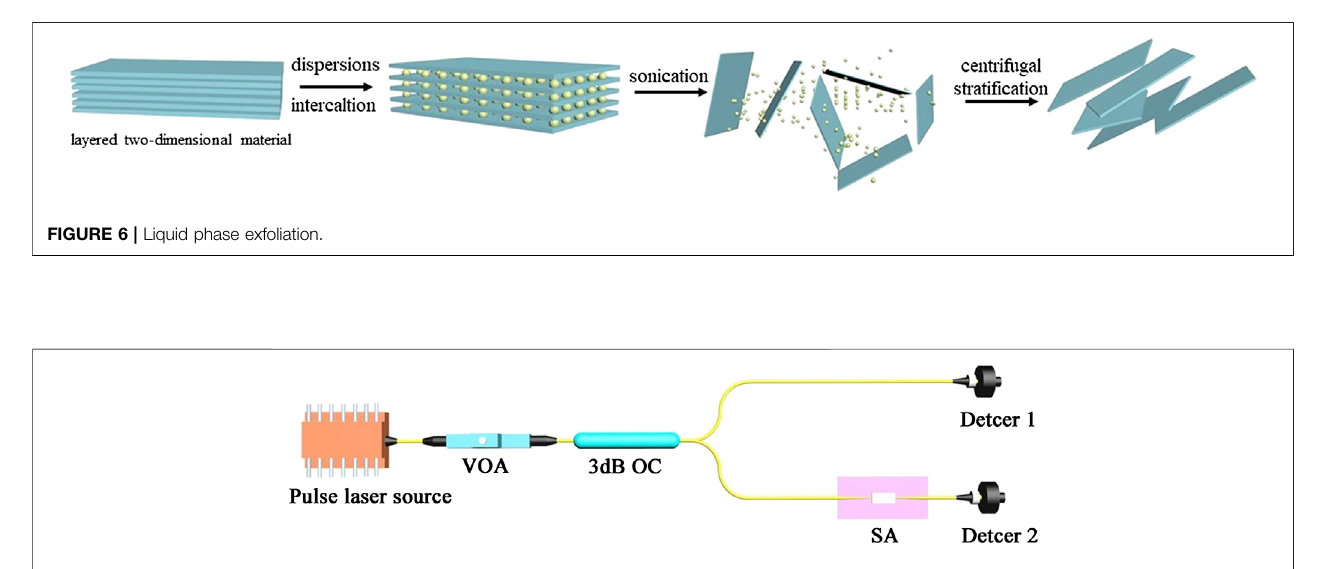
FIGURE 7 | Experimental device for measuring nonlinear saturation absorption characteristics.